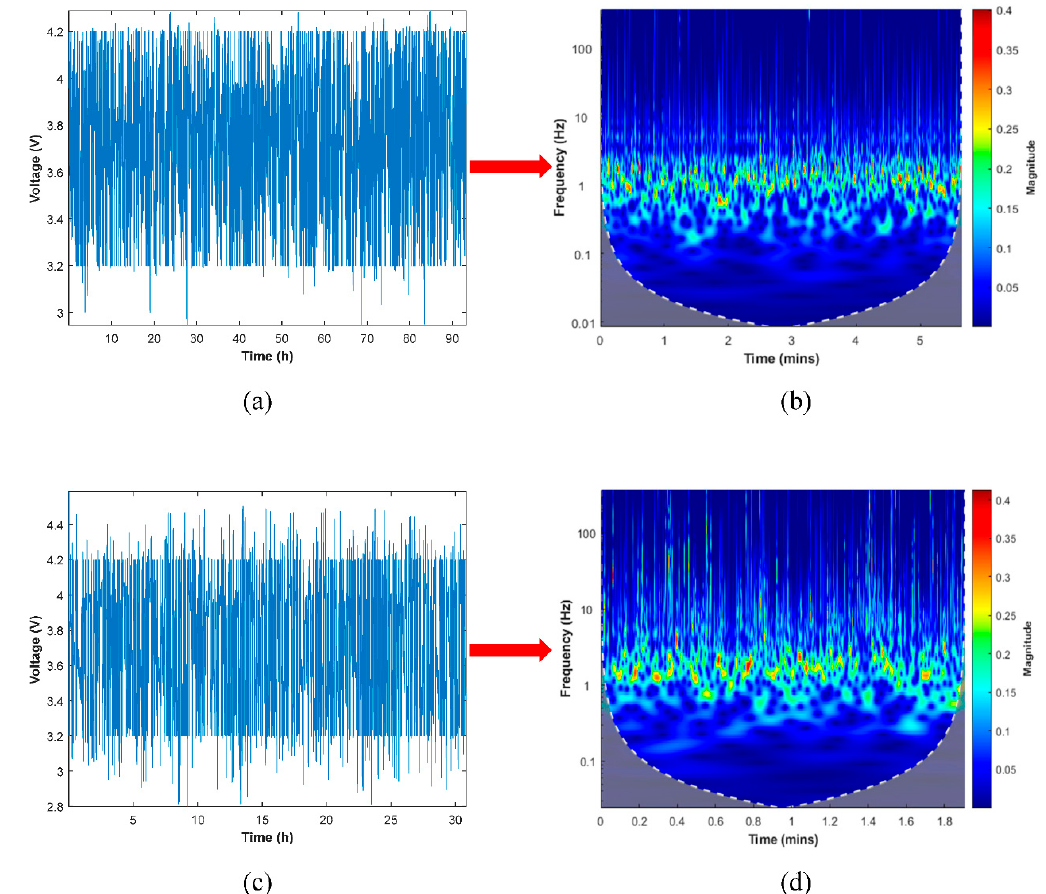
Figure 9. Time-domain measured voltage and plot of TFI energy concentration spectrum of battery cell (RW9): ( a ) measured voltage signal (beginning of life), ( b ) wavelet energy concentration spectrum (beginning of life), ( c ) measured voltage signal (end of life), and ( d ) wavelet energy concentration spectrum (end of life).